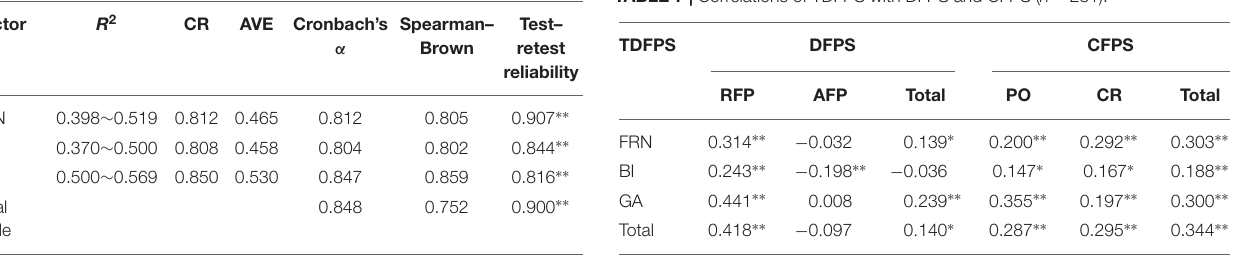
TABLE 6 | Psychometric properties of the TDFPS ( n = 585).